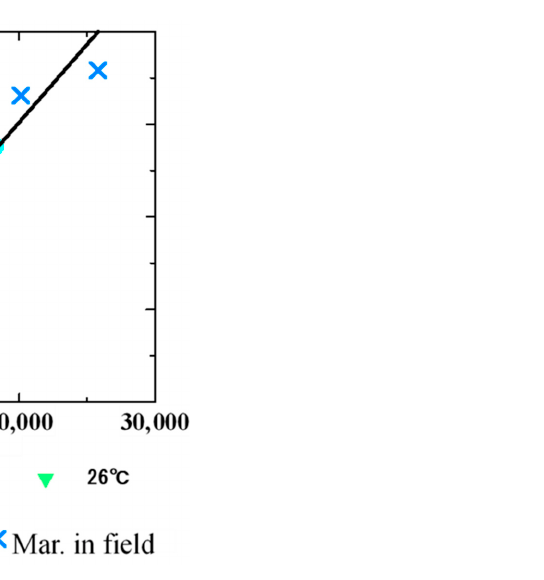
Figure 18. The relationship between turbulent intensity ( Re w ) and the concentration of suspended solids. The relationship between Re w and SS observed in the field was also investigated. The hourly average of T, U bw and Reynolds number were estimated from the time series of velocity observed in the field in September 2015 and March 2016 as shown in Figure 19. The period in which SS was stable for about an hour was extracted, and the relationships with the turbulence intensity and wind speed in the meantime were evaluated. The turbulence increased more in March when the westerlies occurred than in September, and the sediment was highly resuspended. No significant fluctuations were observed in the predominant period T in the field observation results, suggesting that the increase in the Reynolds number is highly dependent on U bw .